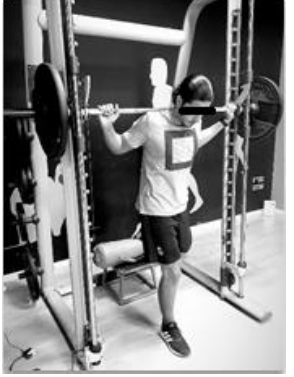
Figure 2. Unilateral squat (UT). Figure 3. T-agility